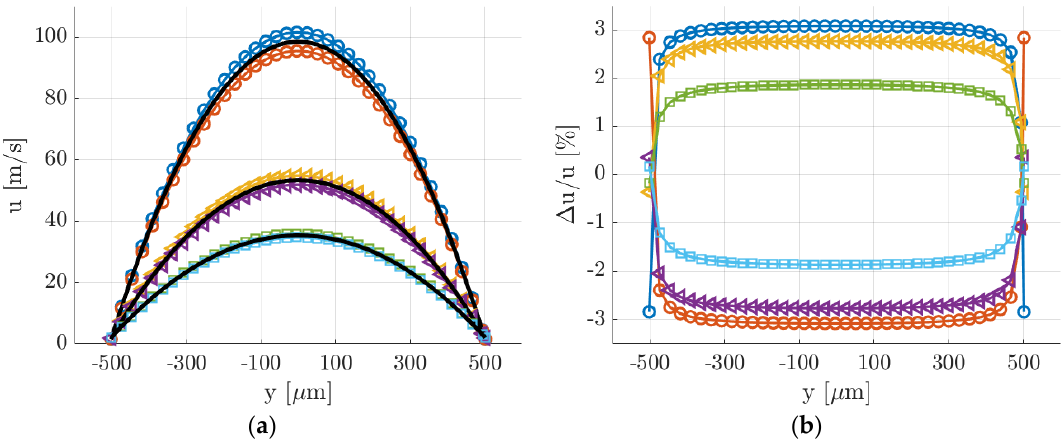
Figure 8. ( a ) Analytical velocity profiles 𝑢(𝑦, 𝑡) at 𝑡 = 100 s (O), 1000 s ( ), and 2000 s ( ☐ ) during the experimental run. The evolution of 𝑢(𝑦, 𝑡) during the recording of 𝑁 𝑖 = 20 consecutive images is illustrated. At each time 𝑡 , the figure reports: the velocity profile captured by the first image of the group; the velocity profile captured by the last image of the group; the average velocity profile (solid black lines) that the image resulting from the average of the 𝑁 𝑖 images would represent. ( b ) Relative variation of the velocity profile with respect to the average velocity profile at 𝑡 = 100 s (O), 1000 s ( ), and 2000 s ( ☐ ).